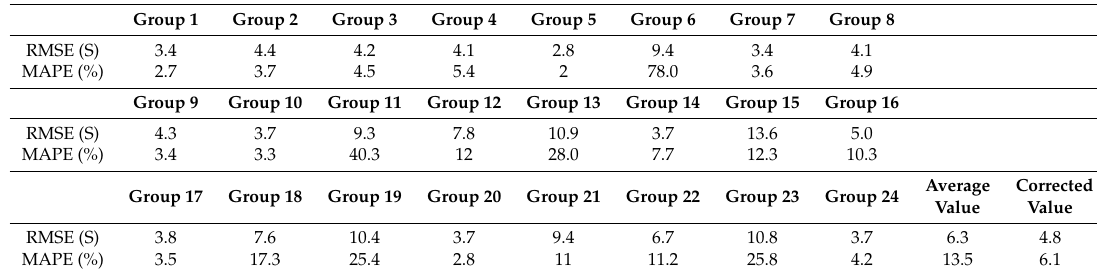
Table 8. Error evaluation in predicting phase for Sort